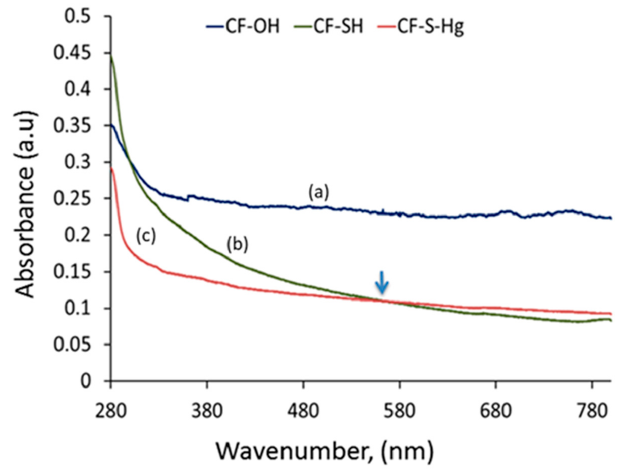
Figure 3. UV-vis absorption spectra of ( a ) CF-OH, ( b ) CF-SH, and ( c ) CF-SH-Hg.